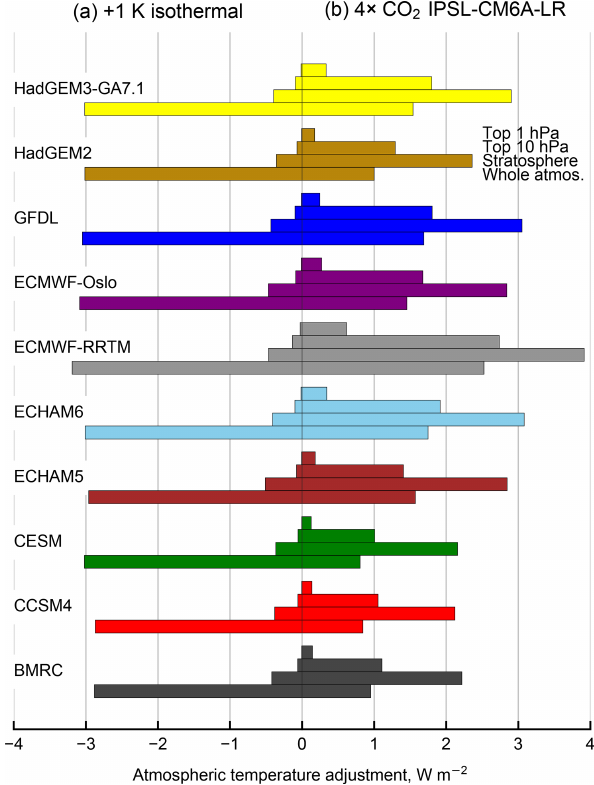
Figure 6. Layer contributions to the TOA temperature adjustment in each kernel considered in this study. From top to bottom the four bars show 1hPa to TOA, 10hPa to TOA, tropopause to TOA (i.e. stratospheric adjustment) and surface to TOA. (a) The effect of a uniform 1K increase in atmospheric temperature on TOA fluxes, as diagnosed directly from the radiative kernel. (b) The kernels con- voluted with atmospheric profiles from the IPSL-CM6A-LR model under an atmosphere-only quadrupled CO 2 run (RFMIP piClim- 4 × CO 2 minus piClim-control